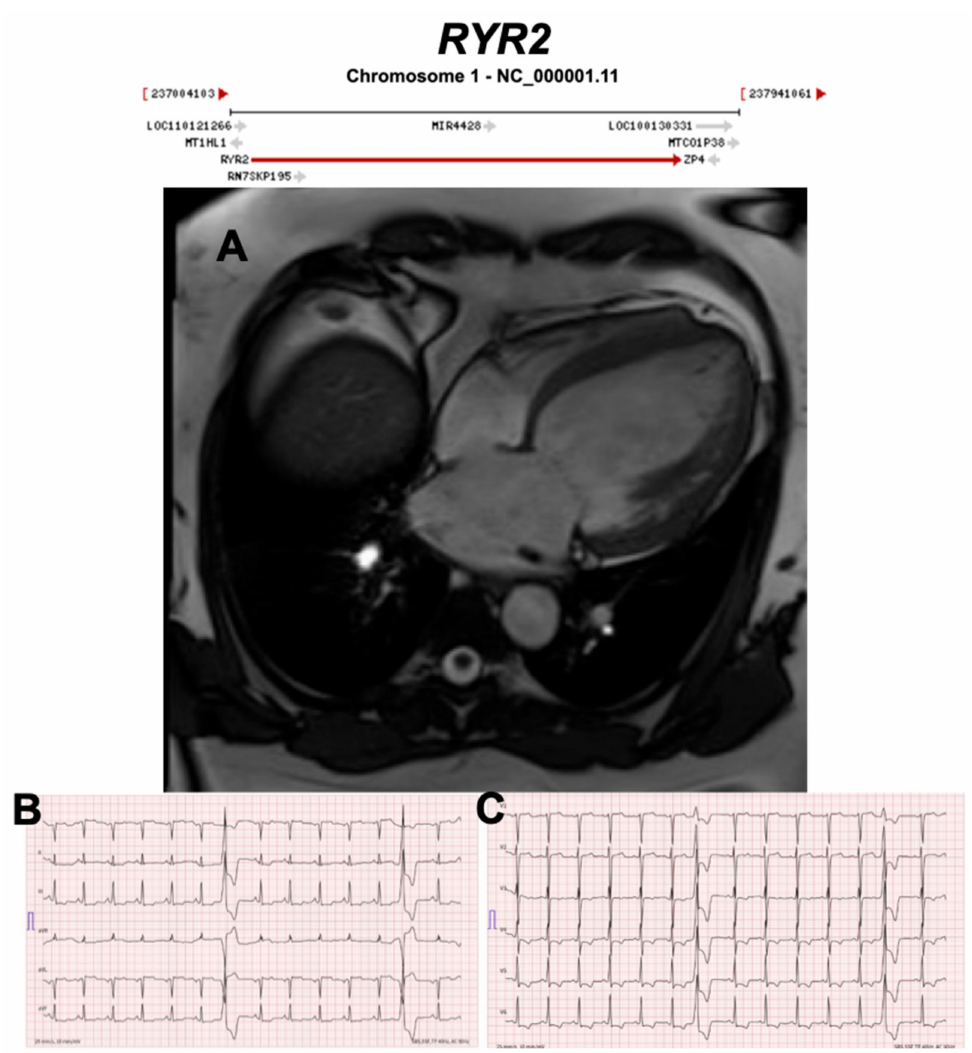
Figure 17. Exemplar MRI and ECG finding found in ACM patients with RYR2 mutations. ( A ) CMR of a patient with RYR2 p.Trp98Ter mutation showing dilated cardiomyopathy; ( B , C ) 12-lead ECG showing inverted T waves in leads II, III, aVF, V3–V6, and two premature ventricular complexes originating from the anterobasal left ventricle. Reproduced with permission from Costa et al. (2020)